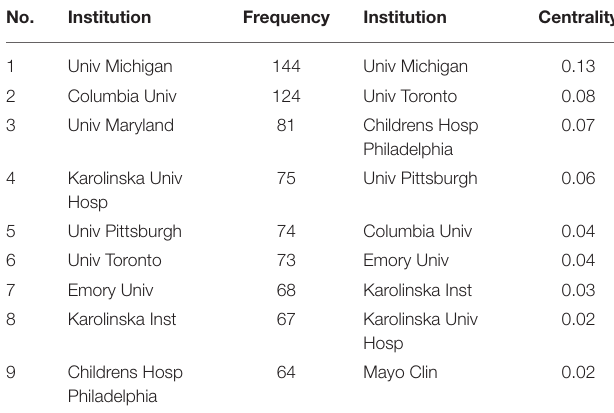
TABLE 3 | Top 10 institutions by publication frequency and centrality.